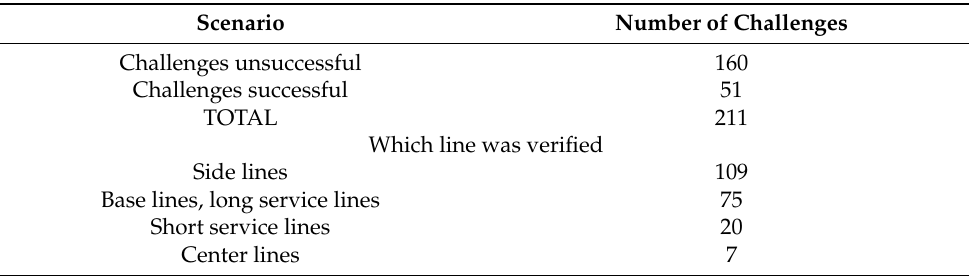
Table 4. Distribution of successful and unsuccessful